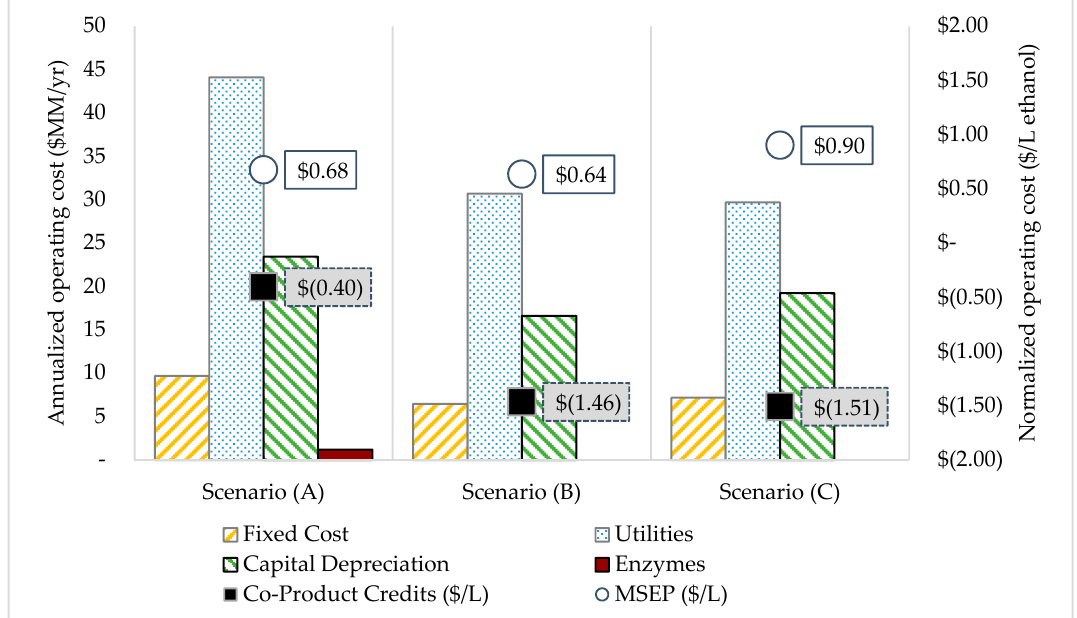
Figure 5. Annual operating cost ($ MM/year) and normalized operating cost ($/L ethanol) for scenario A, FW fermentation with hydrolysis enzyme and a 2-step distillation system, scenario B, FW fermentation process without enzymes and a 2-step distillation system, and scenario C, FW fermentation process without enzymes and a 1-step distillation system.